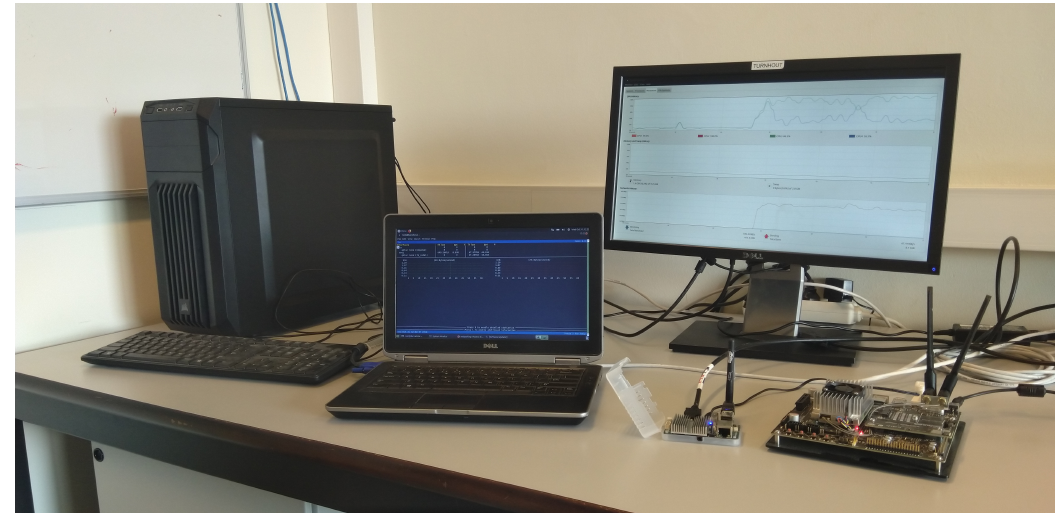
Figure 5. Hybrid deployment of high-end devices and low-end device. From left to right: desktop, laptop, ODROID U3 mini-board, and NVIDIA Jetson TX2 embedded board.